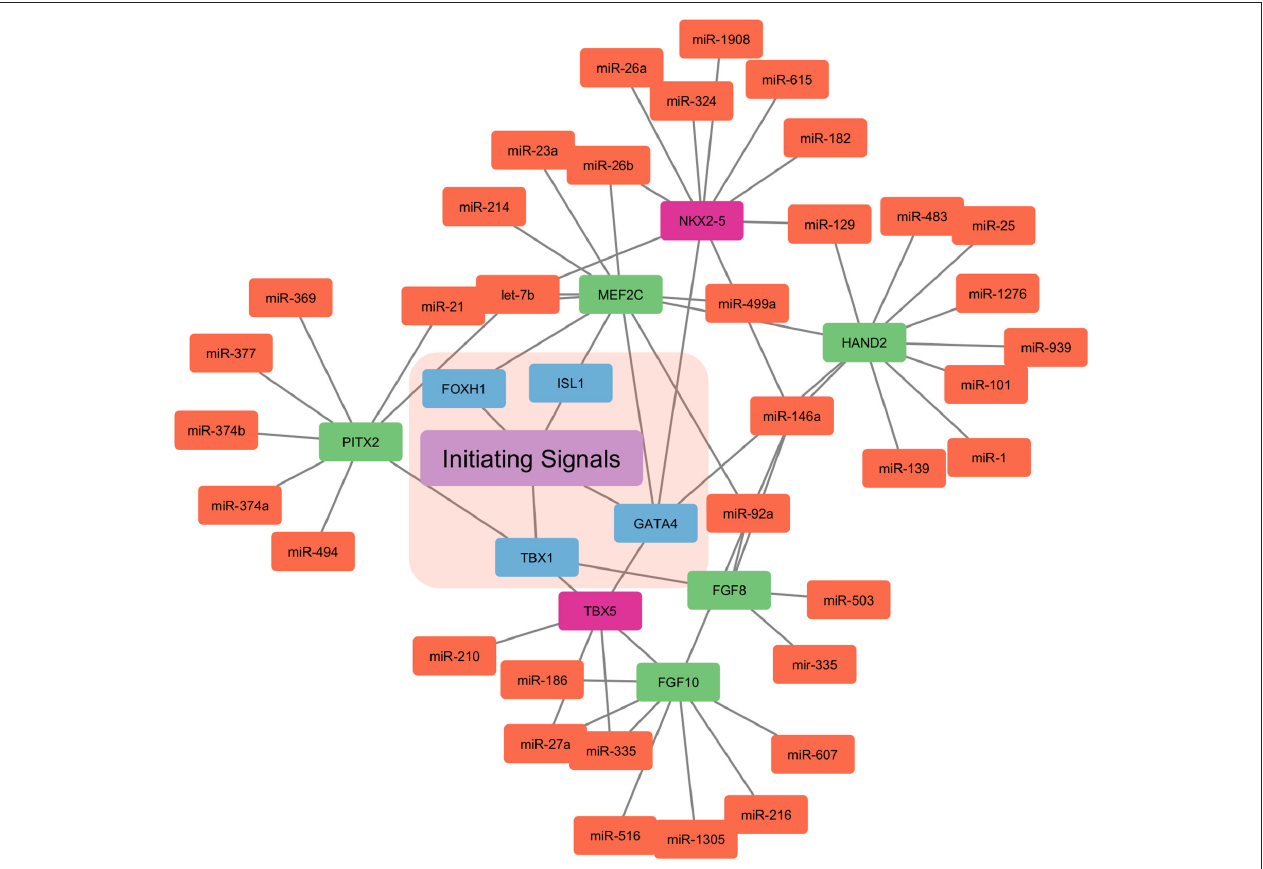
FIGURE 2 | miRNA based regulation of cardiogenesis. The initiating signals, i.e., extrinsic and intrinsic signals in the primary and secondary heart field regulate the cardiogenesis. The nodes in blue represent the central transcription factor orchestrating the developmental signals. Nodes in red represent the transcription factor only expressed in the primary heart field. Whereas, nodes in green represent the transcription factor only expressed in the secondary heart field. Nodes in light coral color represent the miRNAs involved in the control of the overall